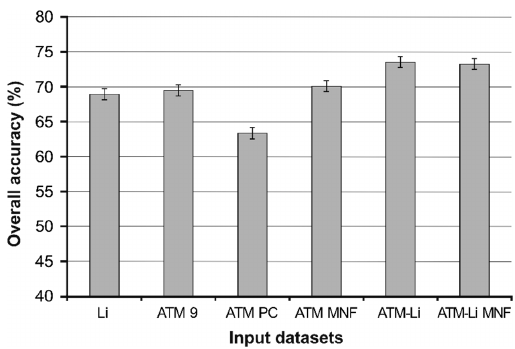
Figure 5. Overall accuracies (OA) of lithological maps generated by applying the OBIA approach to the six input datasets (see Table 2 for description). Error bars represent 95% confidence intervals.